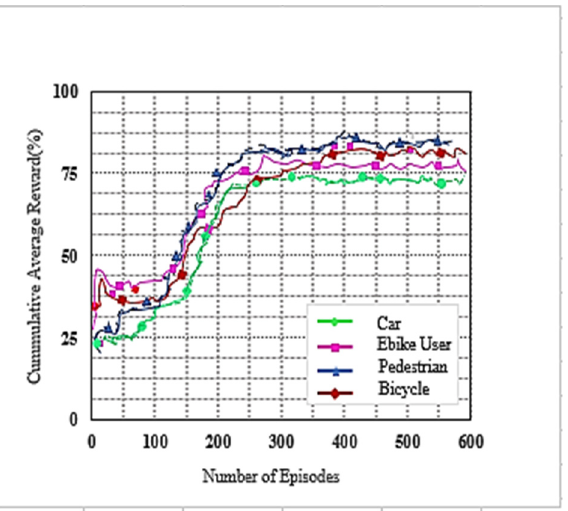
Figure 6. Number of wasteful HO as a function of the number of training episodes for JMLS–DDPG HO scheme.